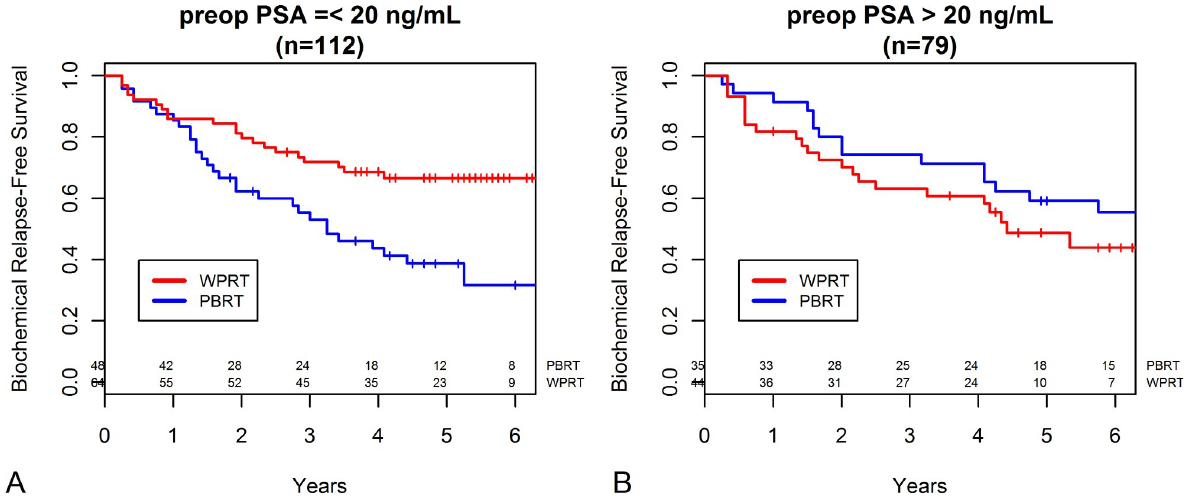
Fig 2. Biochemical relapse-free survival probability stratified based on receipt of whole pelvic radiotherapy (WPRT) or prostate bed-only radiotherapy (PBRT) in (A) patients with preoperative PSA level � 20 ng/mL (n = 112) and (B) patients with preoperative PSA level > 20 ng/ mL (n = 79).